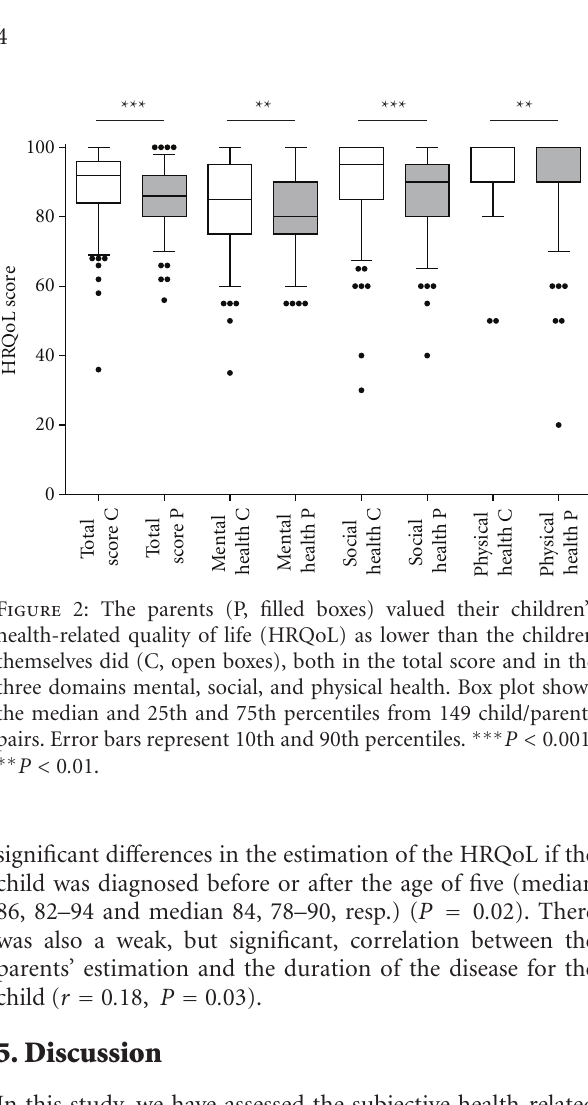
significant di ff erences in the estimation of the HRQoL if the child was diagnosed before or after the age of five (median 86, 82–94 and median 84, 78–90, resp.) ( P = 0 . 02). There was also a weak, but significant, correlation between the parents’ estimation and the duration of the disease for the child ( r = 0 . 18, P = 0 .